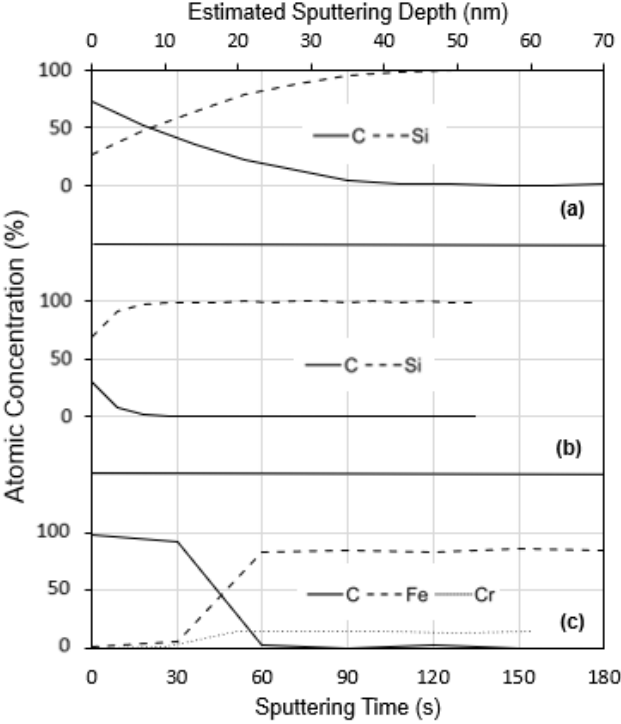
Figure 9. Depth profiles of atomic concentration of the samples with condition E, ( a ) 2-dimensional flat Si plate, ( b ) Si plate attached to the trench sidewall, and ( c ) SUS430 plate attached to the trench sidewall.